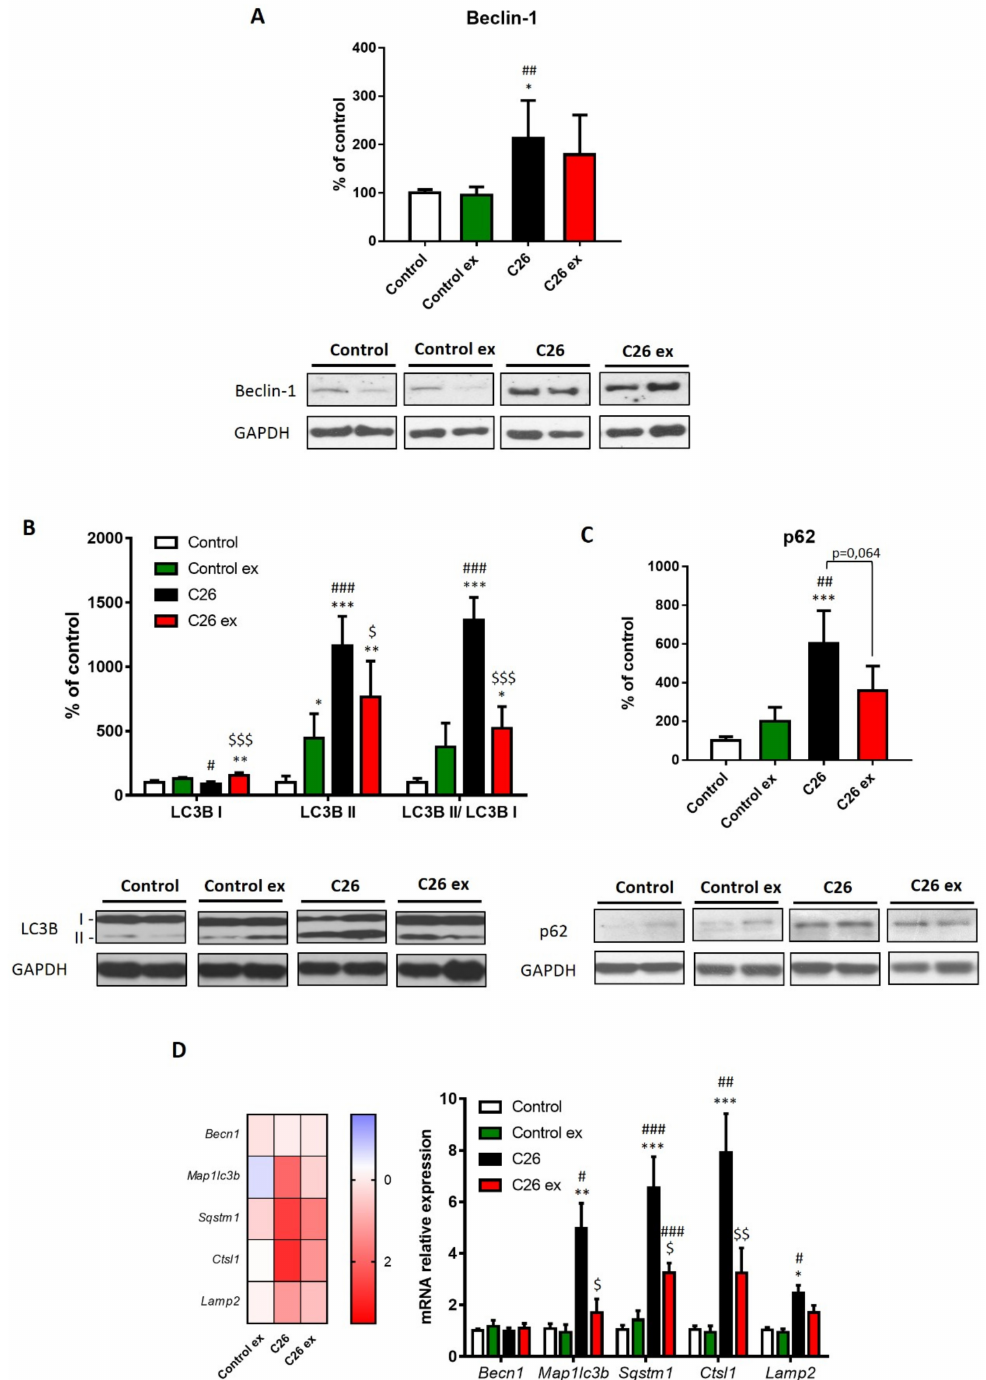
Figure 5. Exercise reduces the expression of markers of autophagy in tumor-bearing mice. Beclin-1 ( A ), LC3B ( B ) and p62 protein levels ( C ; representative blot and quantification) and gene expression of autophagy markers ( D ; heat map and histogram) of control ( n = 5), control exercised (control ex; n = 6) and tumor-bearing mice either sedentary (C26; n = 8) or exercised (C26 ex; n = 8). Protein expression data (means ± SD) are expressed as percentage of control. Gene expression data (means ± SEM) are expressed as ∆∆ ct and relative expression to control, respectively for heat map and histogram. Significance of the differences: * p < 0.05, ** p < 0.01, *** p < 0.001 vs. control; # p < 0.05, ## p < 0.01, ### p < 0.001 vs. control ex; $ p < 0.05, $$ p < 0.01, $$$ p < 0.001 vs.